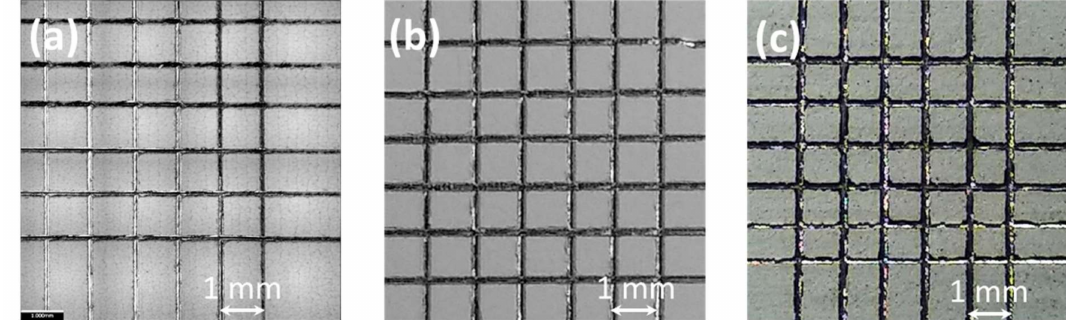
Figure 10. Cross-cut paint adhesion test results on ( a ) dry and ( b ) wet (after 1 week of NSST) AlPF coatings and ( c ) wet